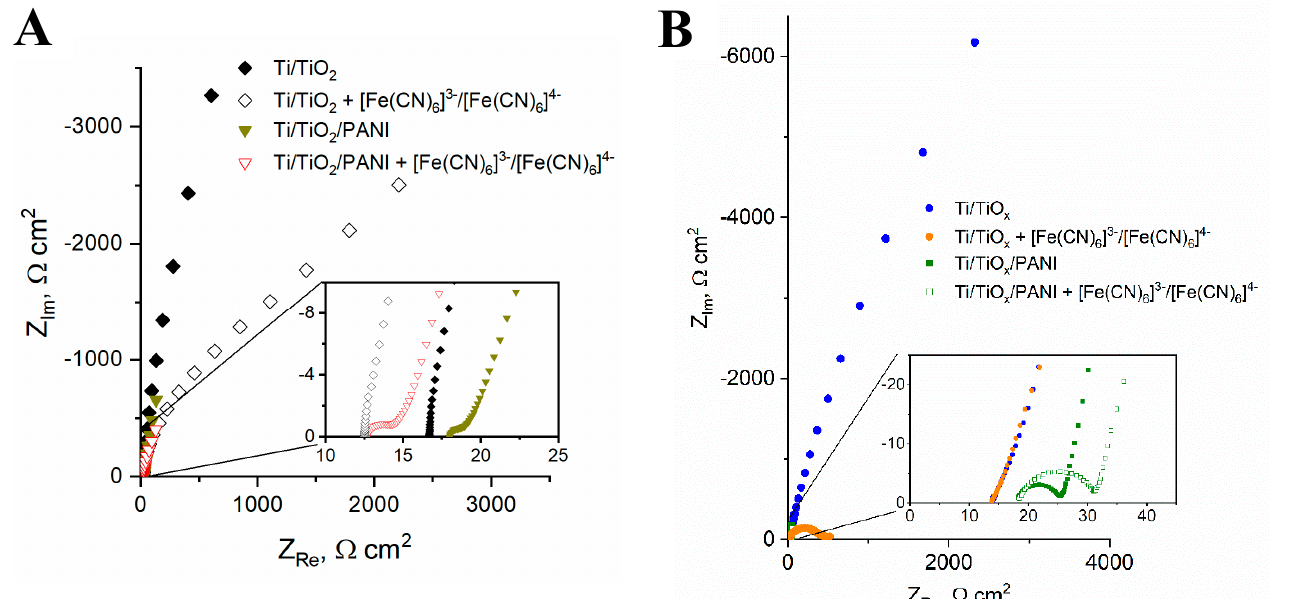
Figure 6. Nyquist plots of Ti/TiO 2 , Ti/TiO 2 /PANI ( A ) and TiO x , TiO x /PANI ( B ) with and without 5 3 − /[Fe(CN) 4 − . Insets: magnification of the mM [Fe(CN) 6 ] 3 − /[Fe(CN) 6 ] 4 − . Insets: magnification of the spectra. 5 mM [Fe(CN) 6 ] 6 ]